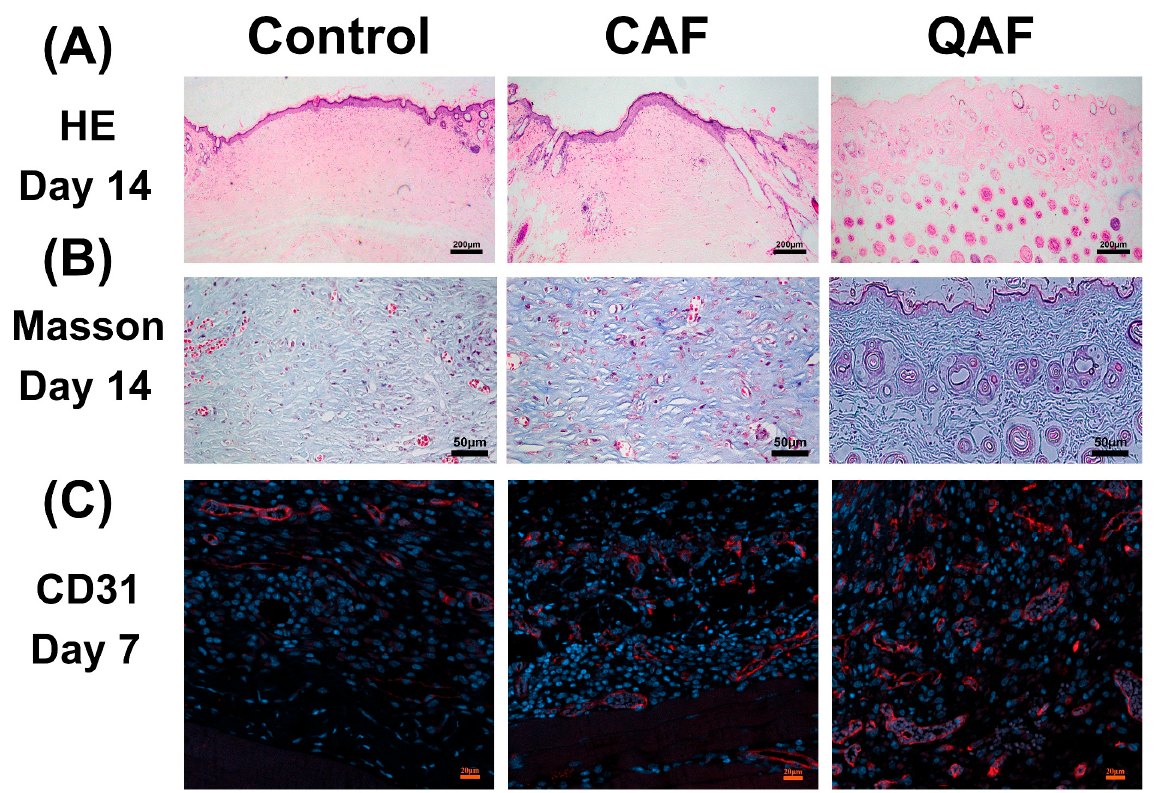
Figure 8. ( A ) HE staining of wound sections at day 14; ( B ) Masson’s staining of wound sections at day 14; ( C ) Immuno fl uorescence staining of CD31 structures at day 7. day 14; ( C ) Immunofluorescence staining of CD31 structures at day